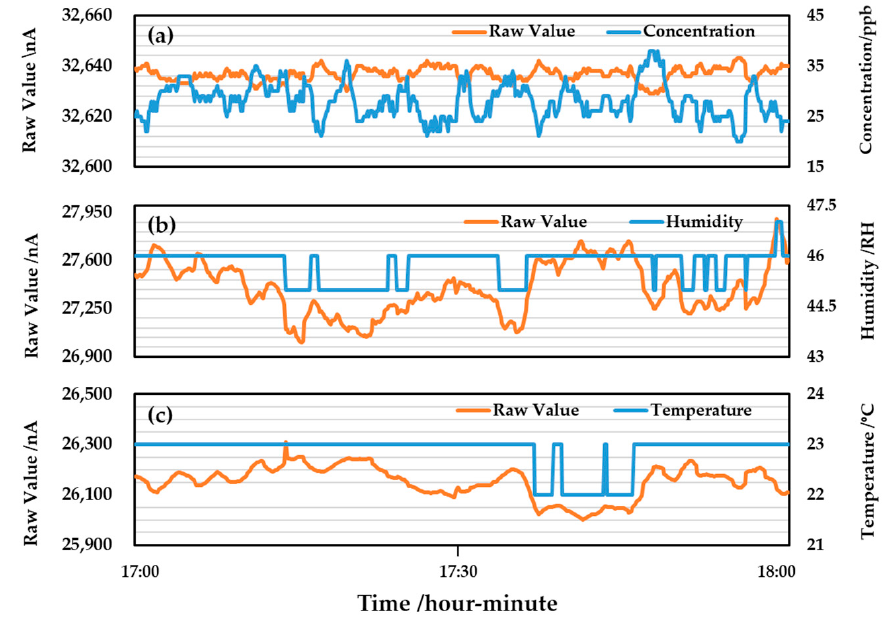
Figure 3. Raw values and corresponding physical quantities of ( a ) concentration, ( b ) temperature, and ( c ) humidity of the O 3 gas sensor on February 1 2021 (17:00–18:00).